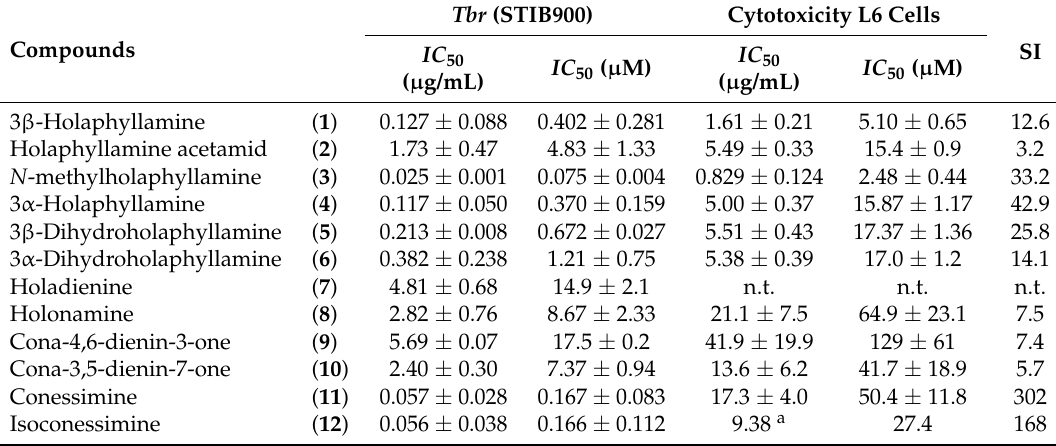
Table 2. In vitro anti-trypanosomal activity and cytotoxicity of isolated alkaloids. Tbr Compounds